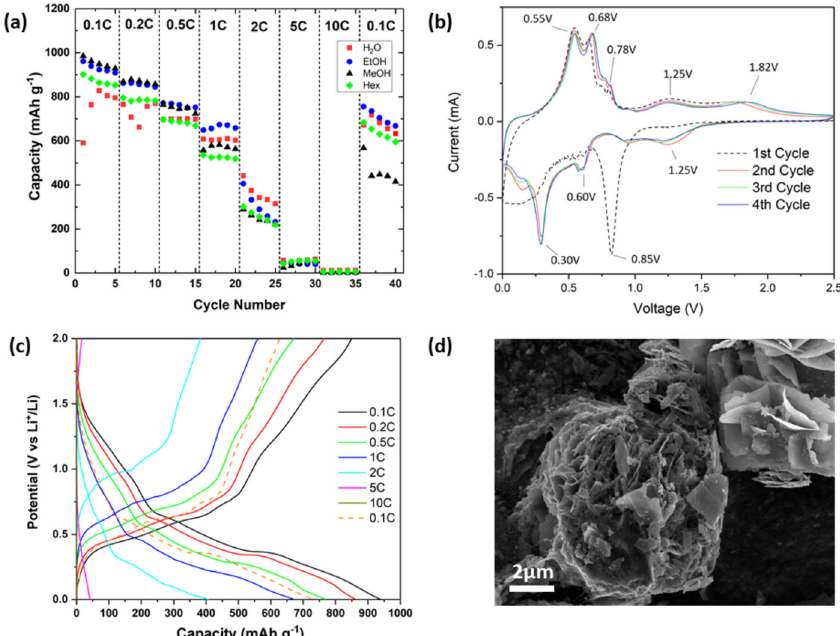
Fig. 7 Electrochemical properties of SnO composites. a rate capability of SnO formed in H 2 O, ethanol, methanol:water (70:30) and hexanol; b cyclic voltammograms acquired between 0 and 2.5V of SnO formed in ethanol at a scan rate of 0.1mVs − 1 ; c representative charge – discharge curve of SnO formed in ethanol and d SEM image of SnO/P3-SWCNT(15%)